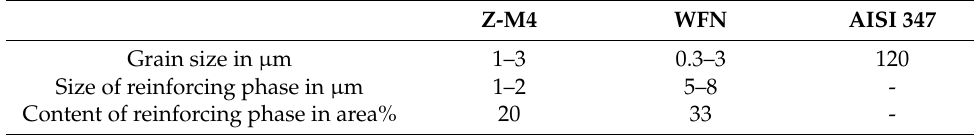
Figure 1. Microstructure including reinforcing phases of Z-M4 ( a,c ), WFN ( b,d ) and AISI 347 ( e ) observed by light optical microscopy ( a,b ) and by EBSD ( c,d,e ). Table 5. Grain and particle sizes of the investigated materials. Table 5. Grain and particle sizes of the investigated materials.